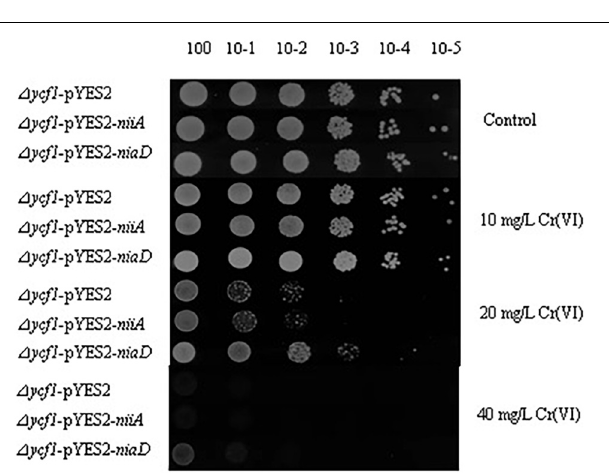
FIGURE 3 | Functional complementation of Cr(VI)-sensitive yeast mutants on selective media. Mutant strains ( (cid:49) ycf1 ) were transformed with empty vector pYES2, pYES2- niiA or pYES2- niaD . Diluted transformant cultures were spotted on SD-Ura medium with or without metal supplement as indicated.